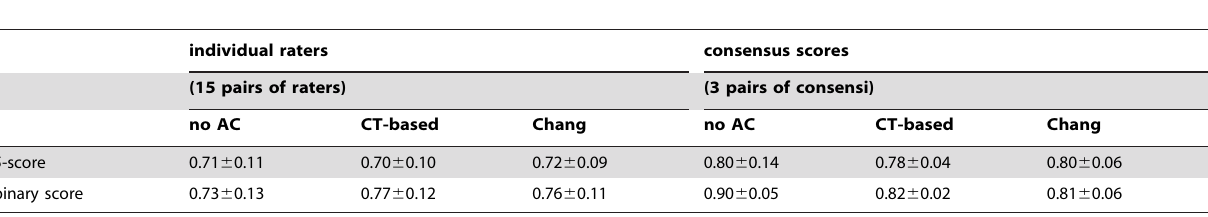
individual raters consensus